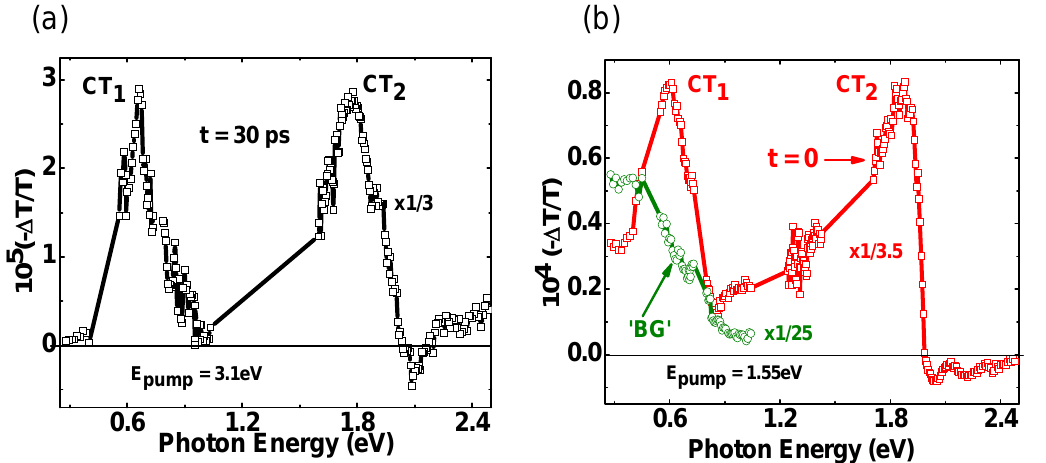
Figure 4. (color on line) ( a ) The transient photomodulation spectrum of RR-P3HT/PCBM blend film at t = 30 ps excited at 3.1 eV, normalized and subtracted from the spectrum at and CT bands; ( b ) Same as in ( a ) but at t = 0 t = 0, that shows the two newly formed CT 1 2 and excited at 1.55 eV, which is below the gap of both polymer and fullerene constituents. The green circles and line represent the background (BG) PA spectrum measured at t = − 5